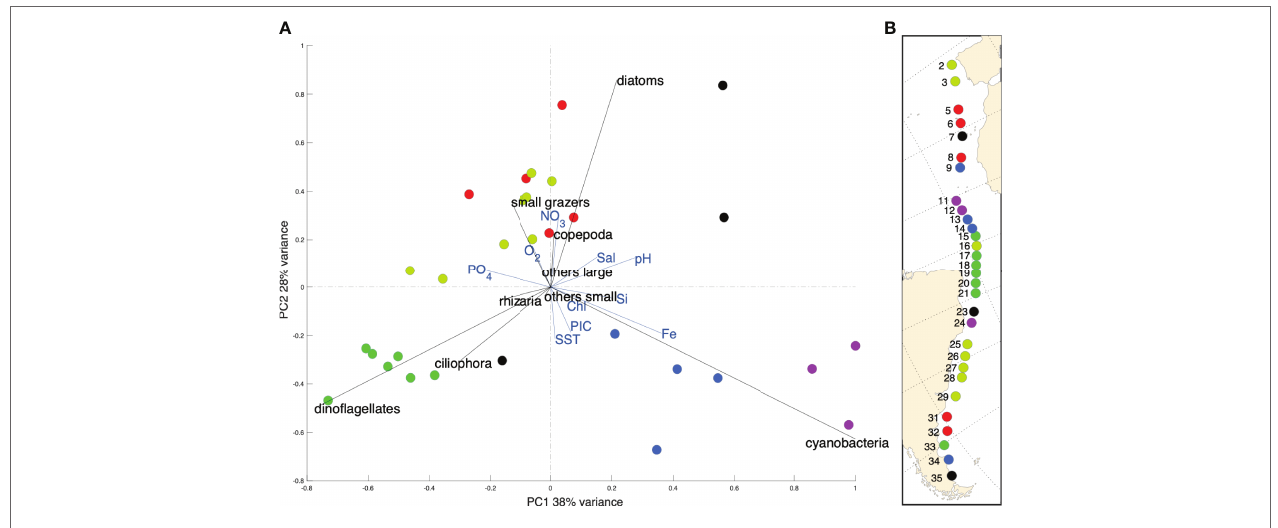
FIGURE 5 | (A) PCA performed on the taxonomic composition at the functional scale (9 taxo-functional groups, Hellinger transformed data) and including key environmental variables. The colors correspond to the 8 characteristic clusters determined via an independent hierarchical analysis based on Euclidean distance. (B) The taxo-functional clusters are projected on the Mission Microbiomes Atlantic transect with corresponding station